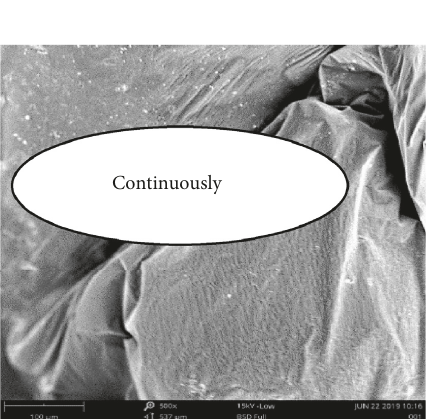
Figure 4: SK90 # matrix asphalt.